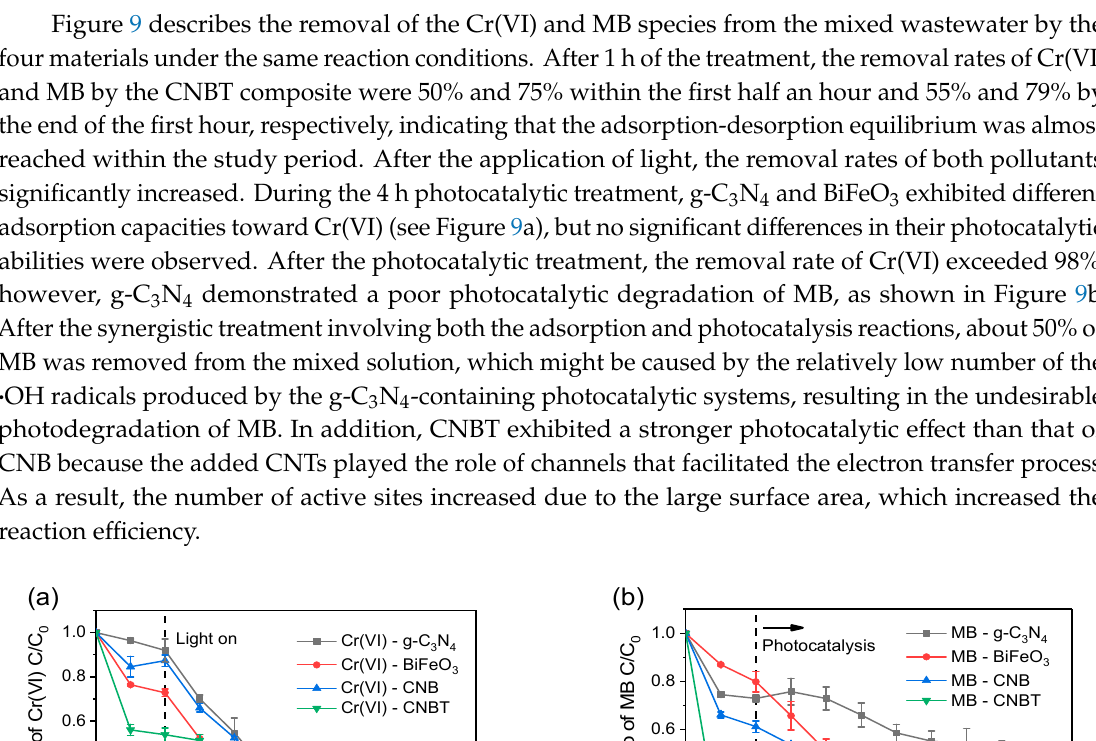
Figure 8. Effect of pH values on the adsorption of Cr(VI) and MB with CNBT: C 0Cr(VI) = 5 mg/L, C 0MB = 20 mg/L, m/V = 2.5 g/L, T = 25 °C.